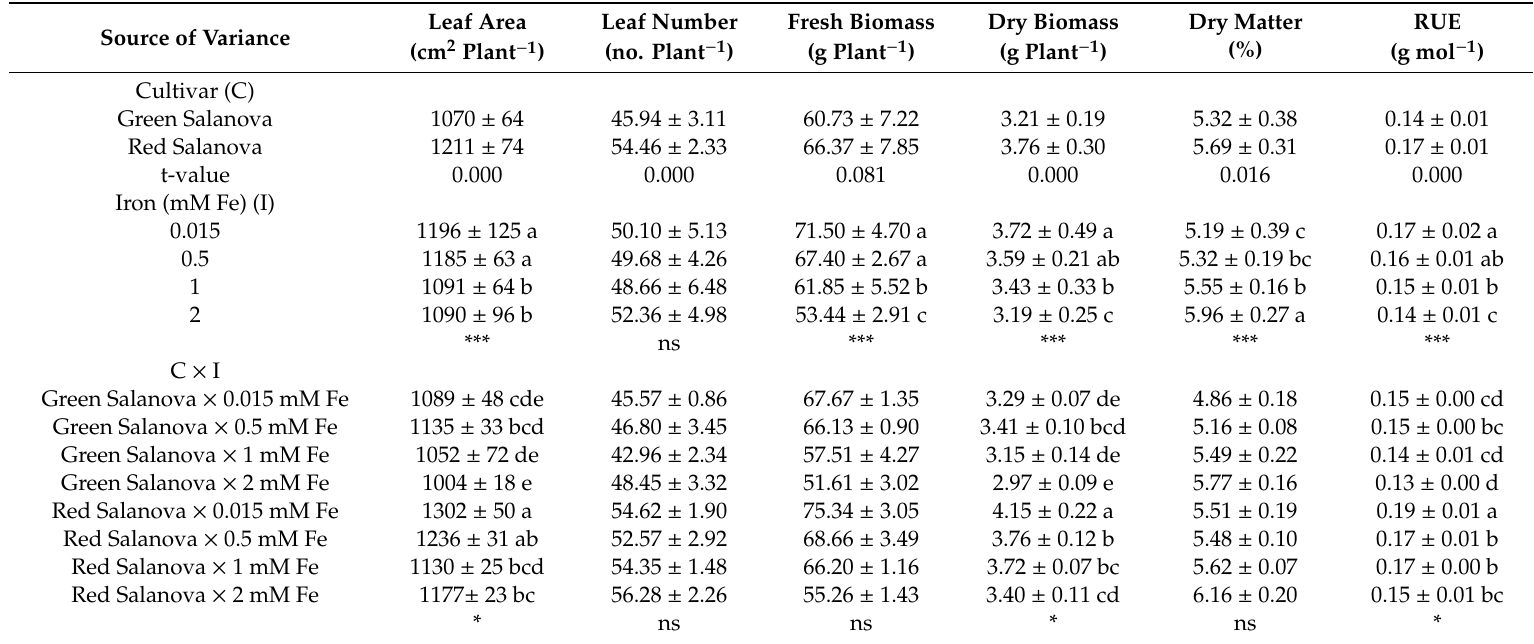
Table 1. Analysis of variance and mean comparisons for leaf area, leaf number, fresh yield, shoot dry biomass, leaf dry matter percentage and radiation use e ffi ciency (RUE) for green and red Salanova butterhead lettuce grown under increasing Fe concentration in the nutrient